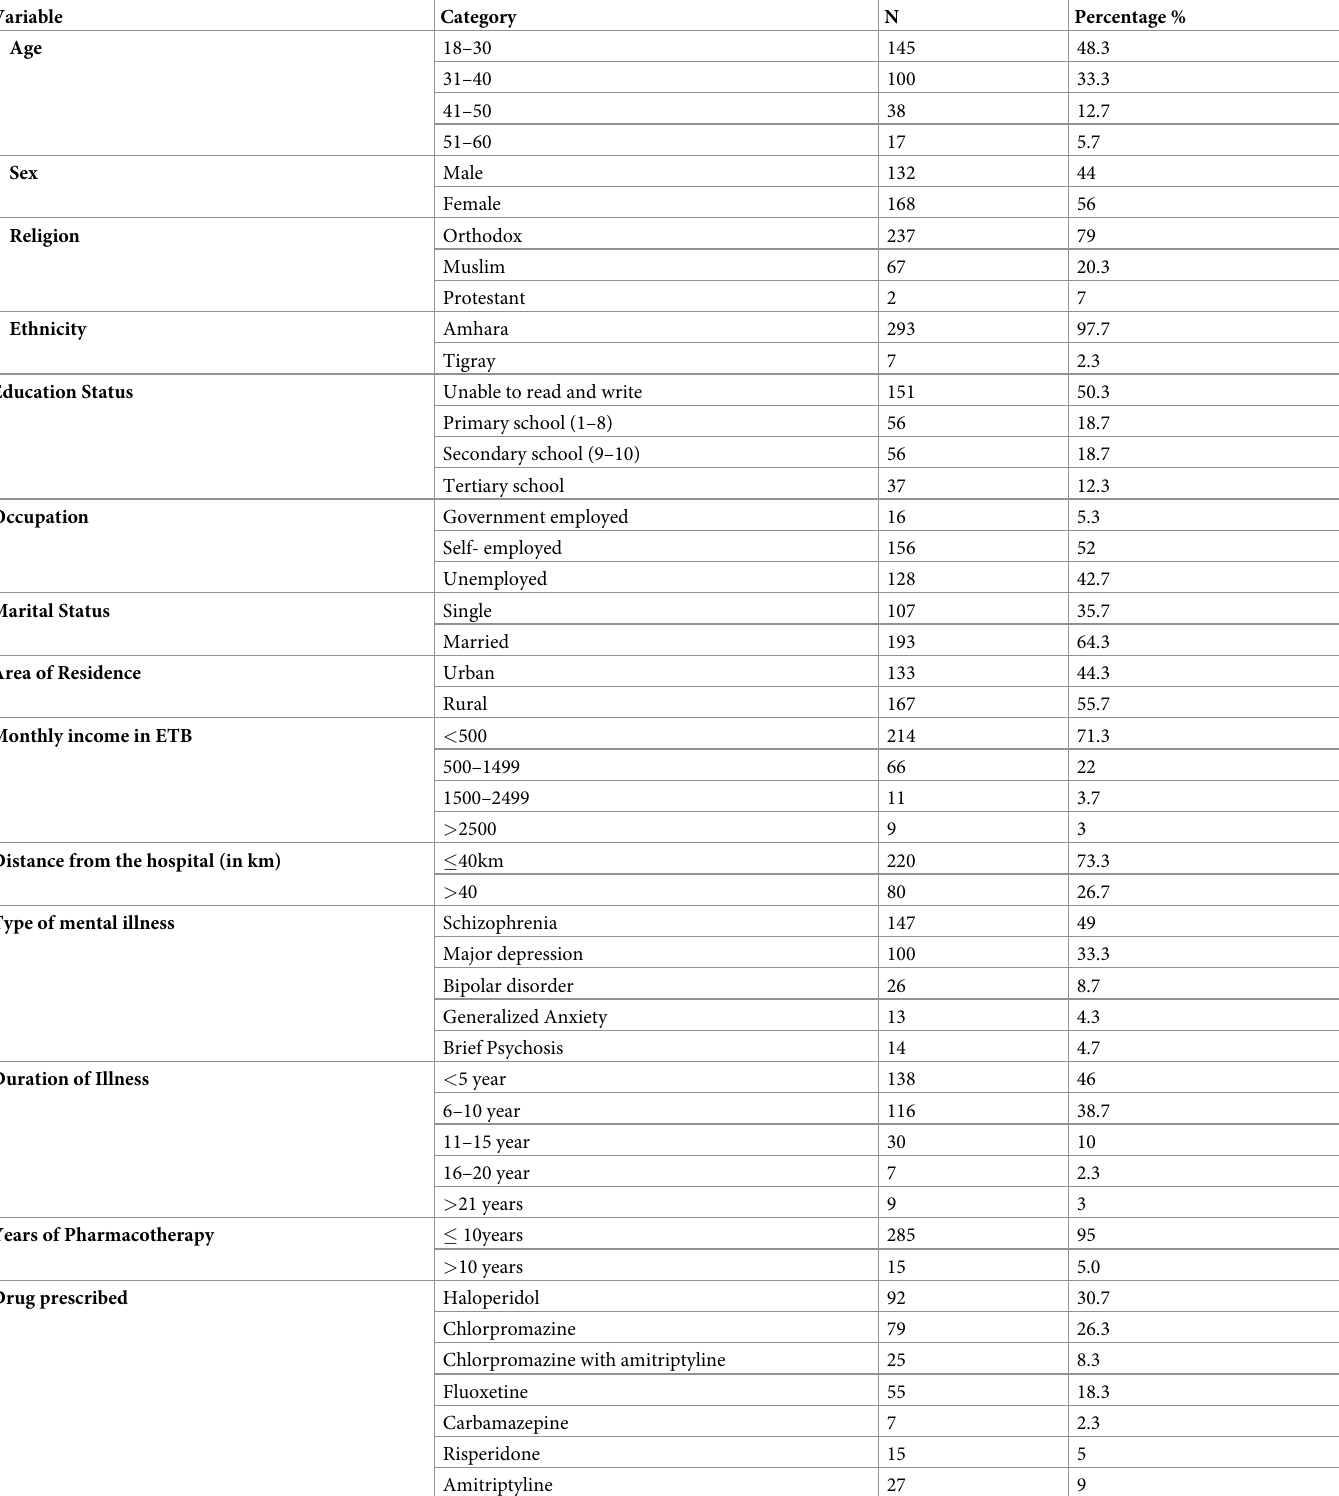
Table 1. Socio-demographic characteristics and clinical features of